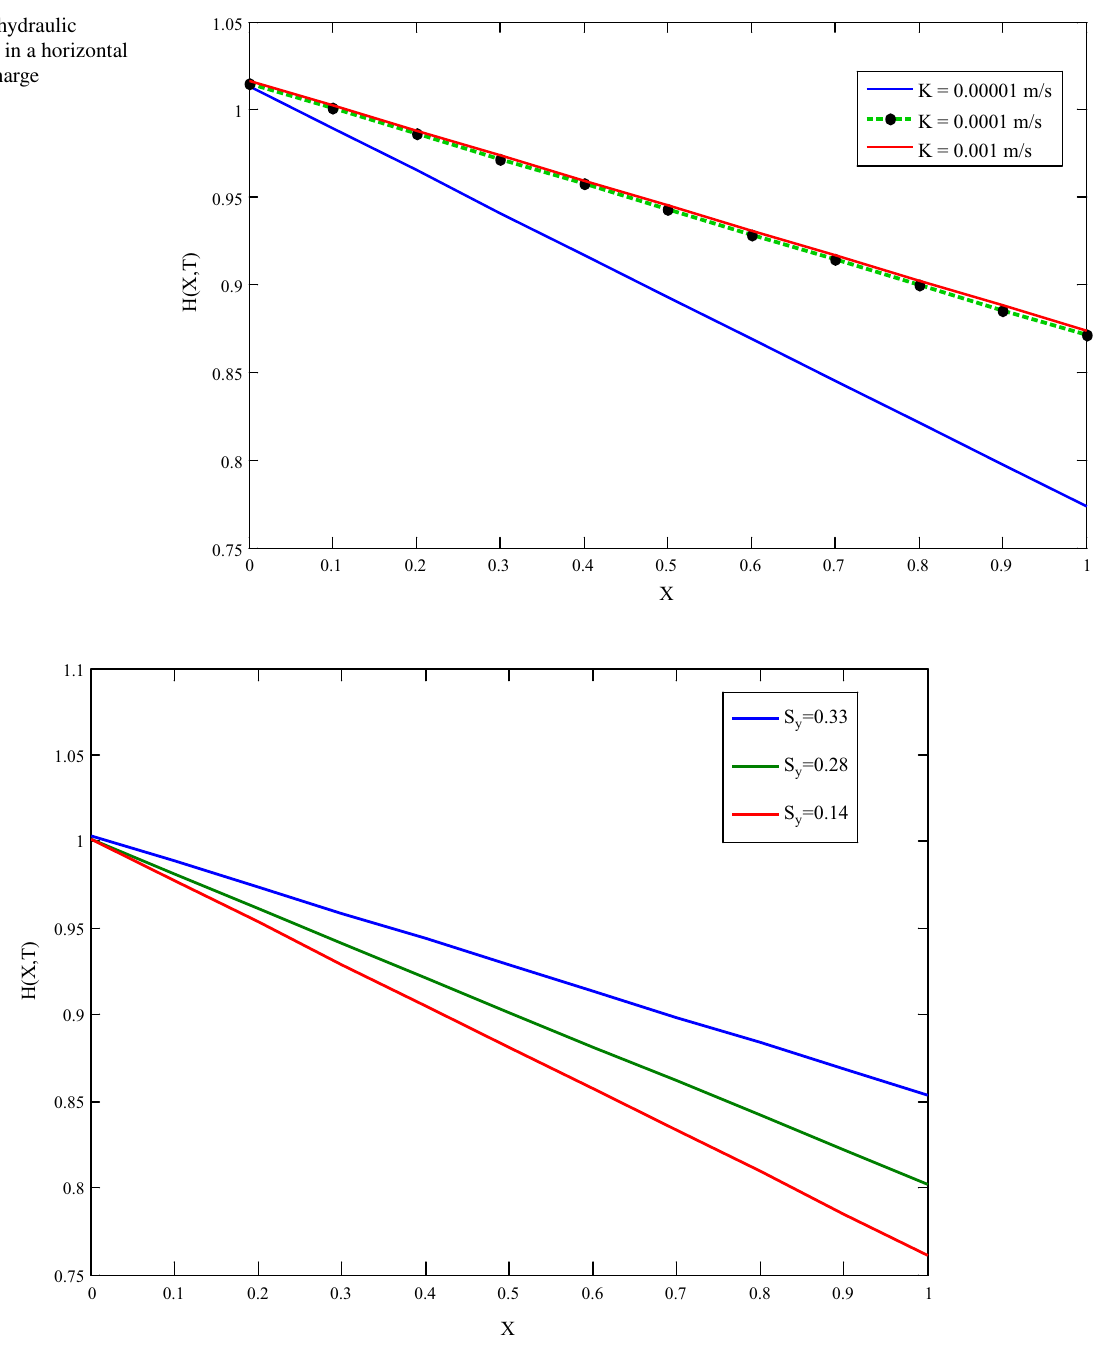
Fig. 4 Effect of specific yield ( S y ) in a horizontal aquifer with